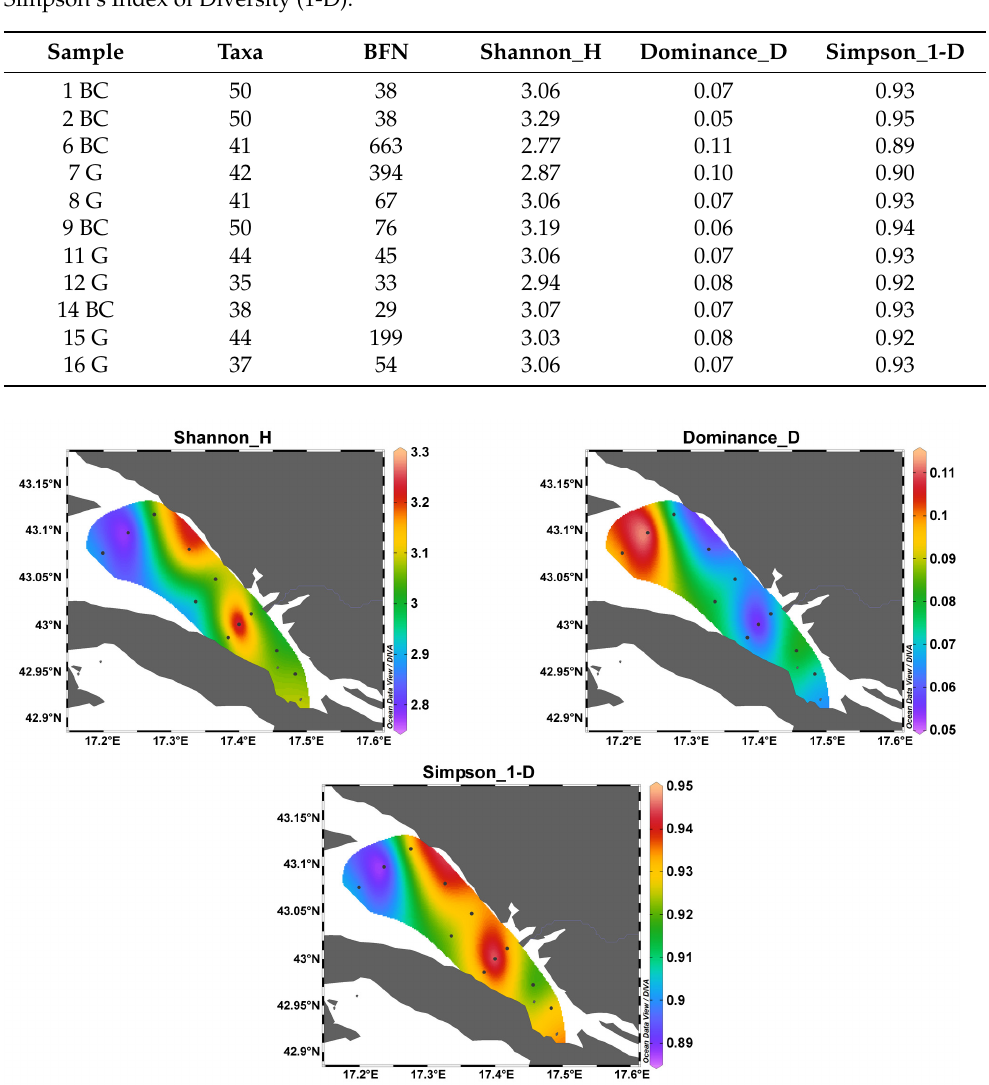
Figure 4. Ecological indices describing the foraminiferal assemblages from the top 2 cm of sediment in the investigated sites (black dots). Gray and white colors indicate land and sea areas respectively Benthic foraminiferal assemblages are characterized by the Shannon (H) index ranging between 2.77 in 6 BC and 3.29 in 2 BC, with a median of 3.03; Dominance (D) varied between 0.05 in 2 BC and 0.11 in 6 BC, with a median of 0.07; finally, the Simpson index (S) is not significantly different in the investigated area with comparable values